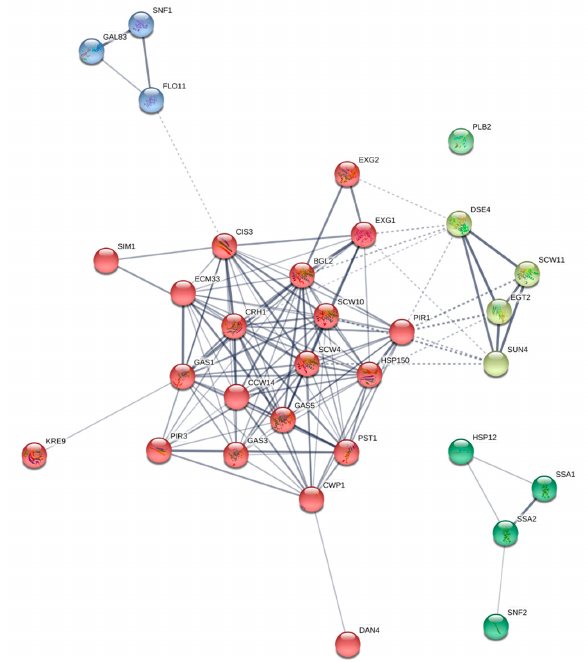
Figure 1. Protein interaction network map built using the STRING v. 11.0 database and based on the 32 cell wall-related proteins identified in total in S. cerevisiae P29 and G1. Proteins are shown as nodes, and the edges represent the interactions between nodes. The strength of the connections is indicated by the edges thickness. Nodes with different colors represent specific clusters obtained from an MCL (Markov Cluster Algorithm) clustering method (four clusters: blue, red, light green, and dark green). PPI (protein-protein interaction) enrichment p -value < 1 × 10 − 16 .